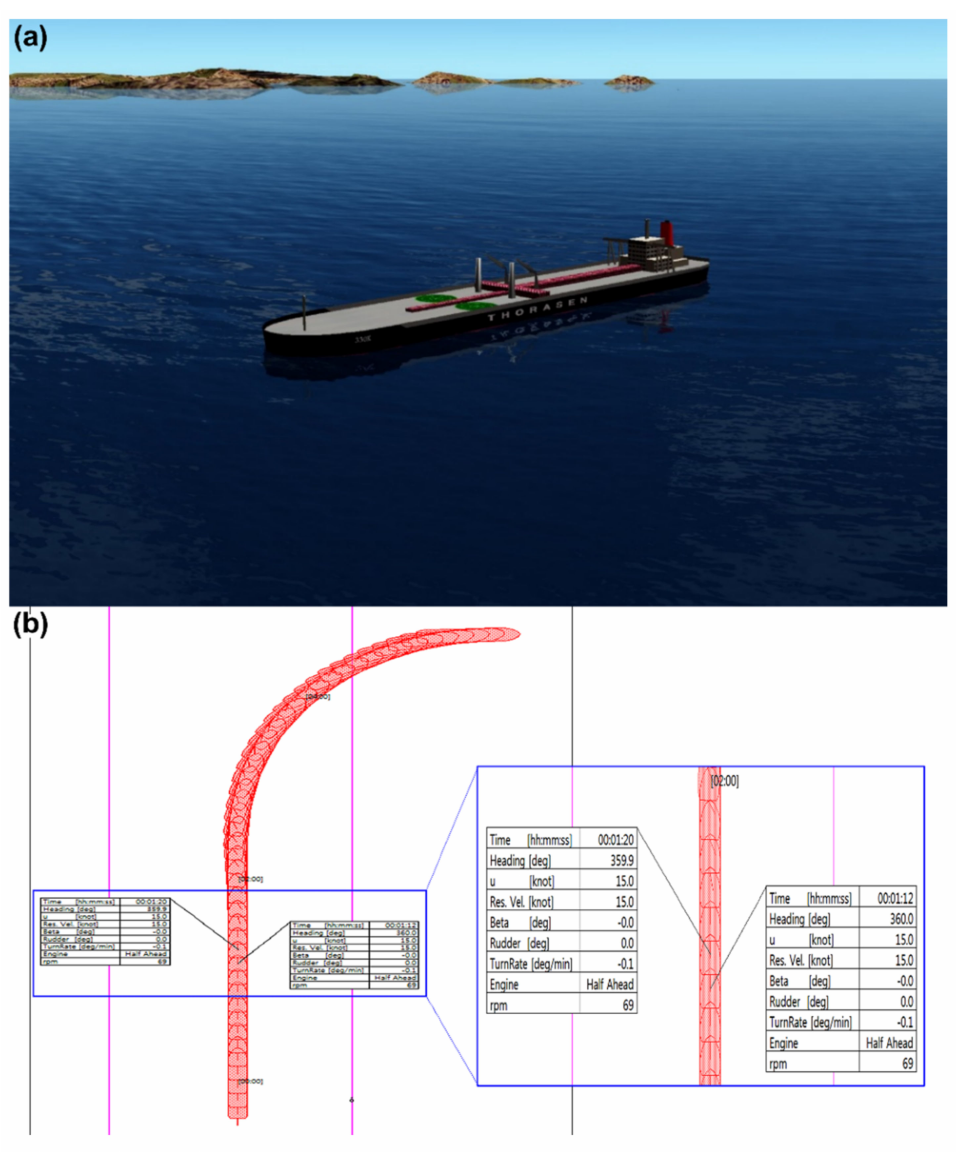
Figure 10. Ship handling simulator: ( a ) tanker ship and ( b ) measured